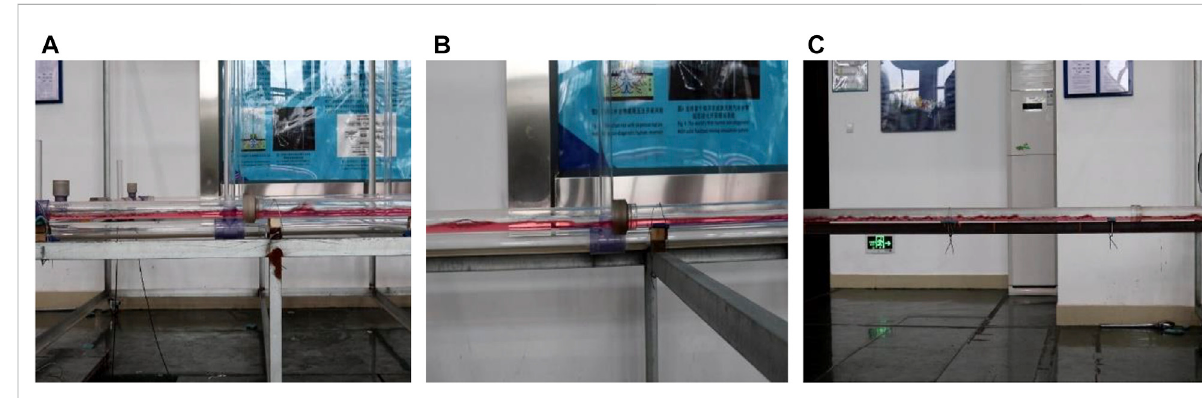
FIGURE 3 Experimental phenomenon of fl ow maldistribution in strati fi ed fl owin horizontalmanifold[ (A) outlet pipe1, (B) outletpipe 2, and (C) inlet